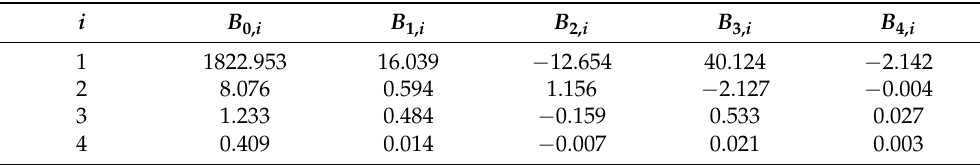
Table 14. Coefficients of multivariate linear regression analysis.